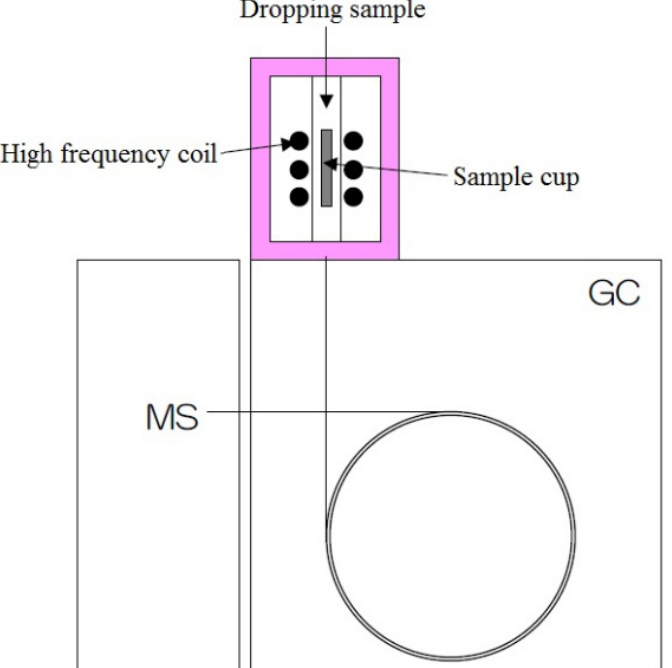
Figure 1. Configuration of Py-GC/MS